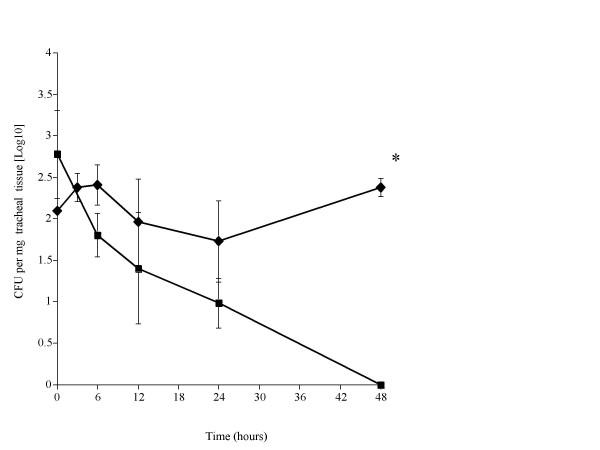
Time course of the change in numbers of S. pneumoniae in the nasopharynx (figure 1), trachea (figure 2), lungs (figure 3) and blood (figure 4) of SP-D-/- (◆) and SP-D+/+ (■) mice infected intranasally with 106 CFU (n = 10 mice at each time point, error bars indicate SEM). * denotes P < 0.01, ** denotes P < 0.05 for SP-D-/- when compared to wildtype at equivalent time point.